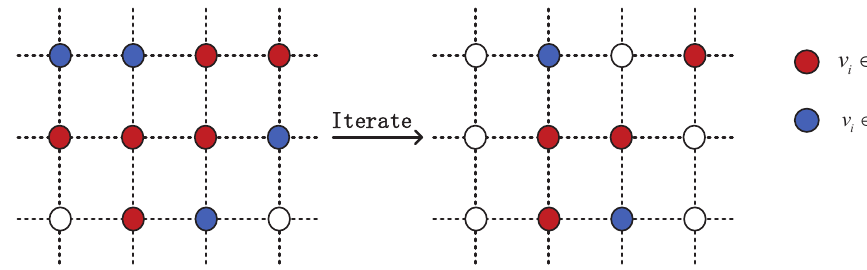
Figure 5. Schematic diagram of the network iteration. The flow chart of this algorithm is shown in Algorithm